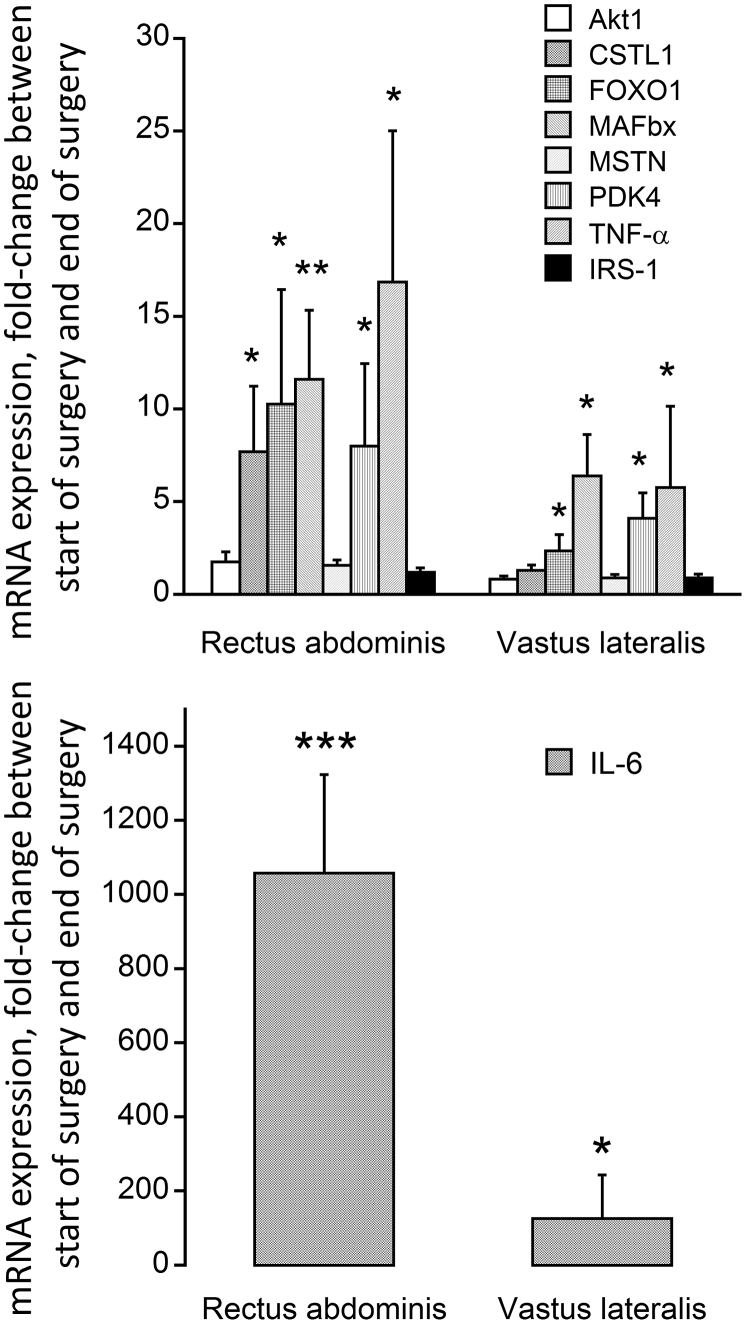
Fold change in (top) Akt1, Cathepsin-L (CSTL1), FOXO1, MAFbx, myostatin (MSTN), PDK4, TNF-α and IRS1 mRNA expression and (bottom) IL-6 mRNA expression in rectus abdominis (local to the site of surgery) and vastus lateralis (distant from the site of surgery site) muscle obtained at the start of surgery and immediately after surgery from participants undergoing major abdominal surgery (n = 15). Values are expressed as fold changes from the value at the start of surgery. *P < 0.05, **P < 0.01, ***P < 0.001, significantly different from the value at the start of surgery.